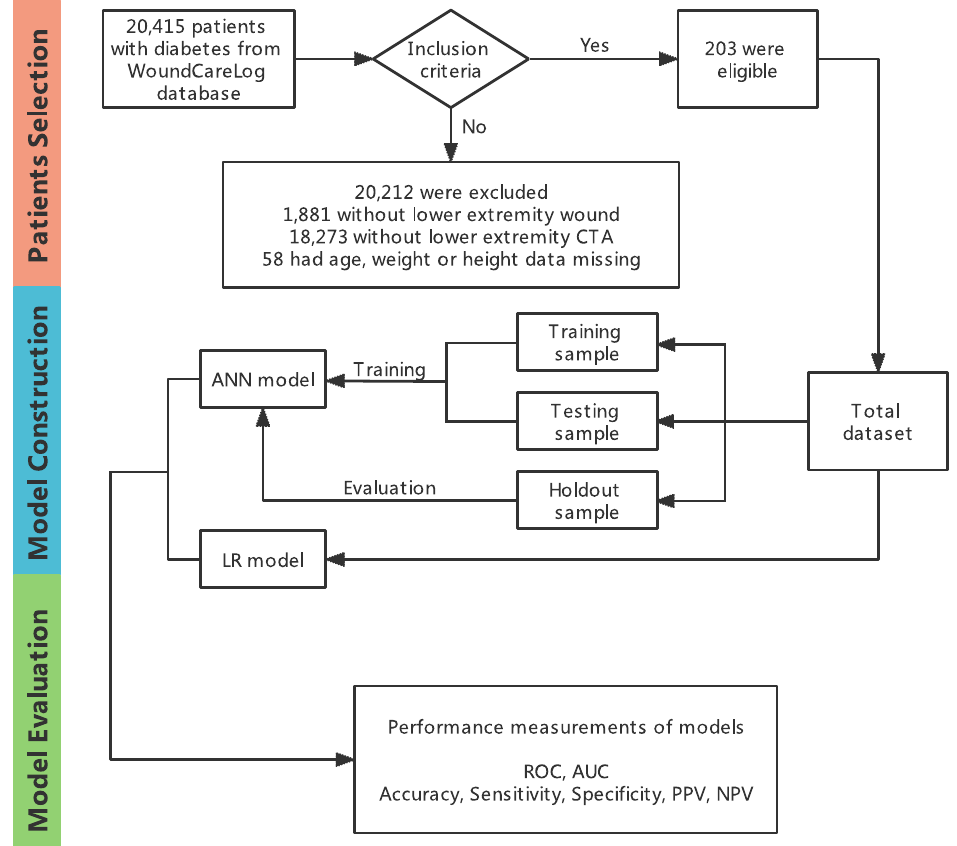
Figure 2. Flow chart of patient selection, model construction and model evaluation.